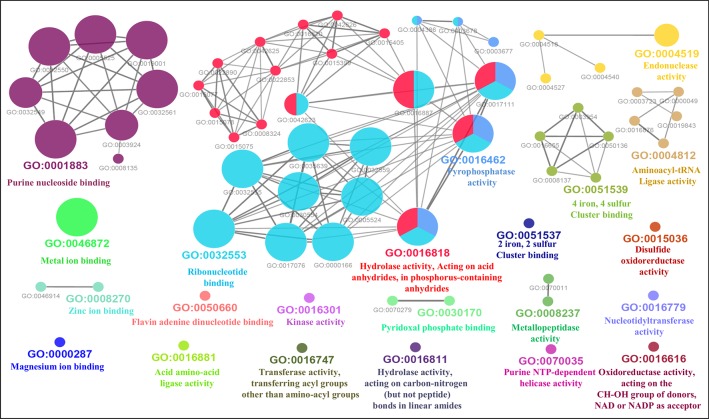
Gene Ontology ClueGO molecular function network of putative MBPs. Functionally enriched GO molecular function network of predicted MBPs was constructed by ClueGO (at kappa score ≥0.4). Each circle in the network represents a node, i.e., specific GO molecular function term and color of the node symbolizes a GO group. The mixed color of the node specifies their involvement in multiple molecular functions. There are 22 final kappa score groups in the GO molecular function network of Ott. Out of 22, 6 were significant groups of GO molecular terms [ribonucleotide binding (GO:0032553), endonuclease activity (GO:0004519), metal ion binding (GO:0046872), purine nucleoside binding (GO:0001883), pyrophosphatase activity (GO:0016462), and hydrolase activity, acting on acid anhydrides, in phosphorus-containing anhydrides (GO:0016818)]. The GO molecular function network also provide pillar for our domain-based and GO biological process classification. This is because molecular activities of most of the significant groups were involved in the processes of gene expression and regulation and metabolism.